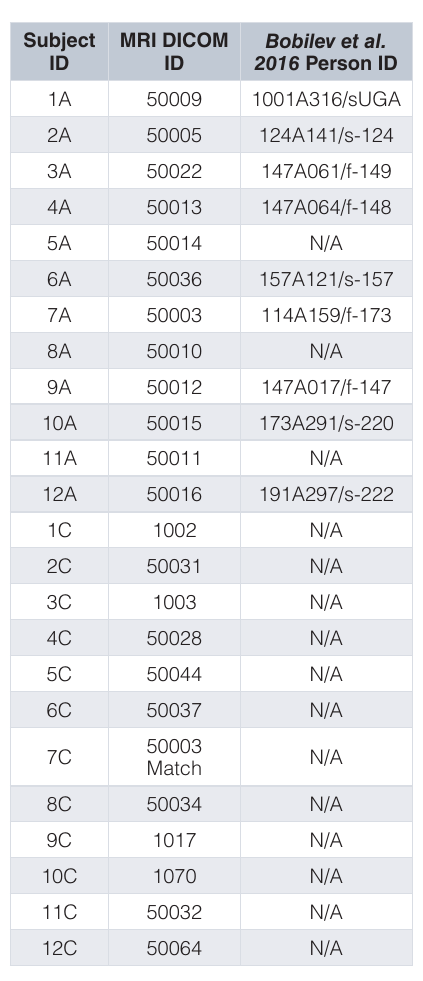
Supplementary Table 2. Subject ID. Subject ID used in this paper, MRI DICOM ID for DICOM